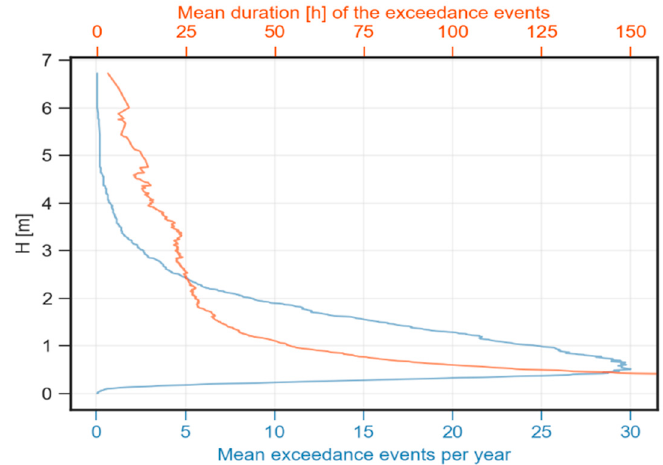
Figure 3. Mean exceedance events per year (N) and mean duration of exceedance events (T) for every unique value of a 25 years agitation time series (H) after applying a POT analysis, assuming 48 h between independent events. Notice that, for the lowest values of H, the values of N are also low since they are exceeded most of the time; indeed, the minimum agitation value is associated with N = 1/25.